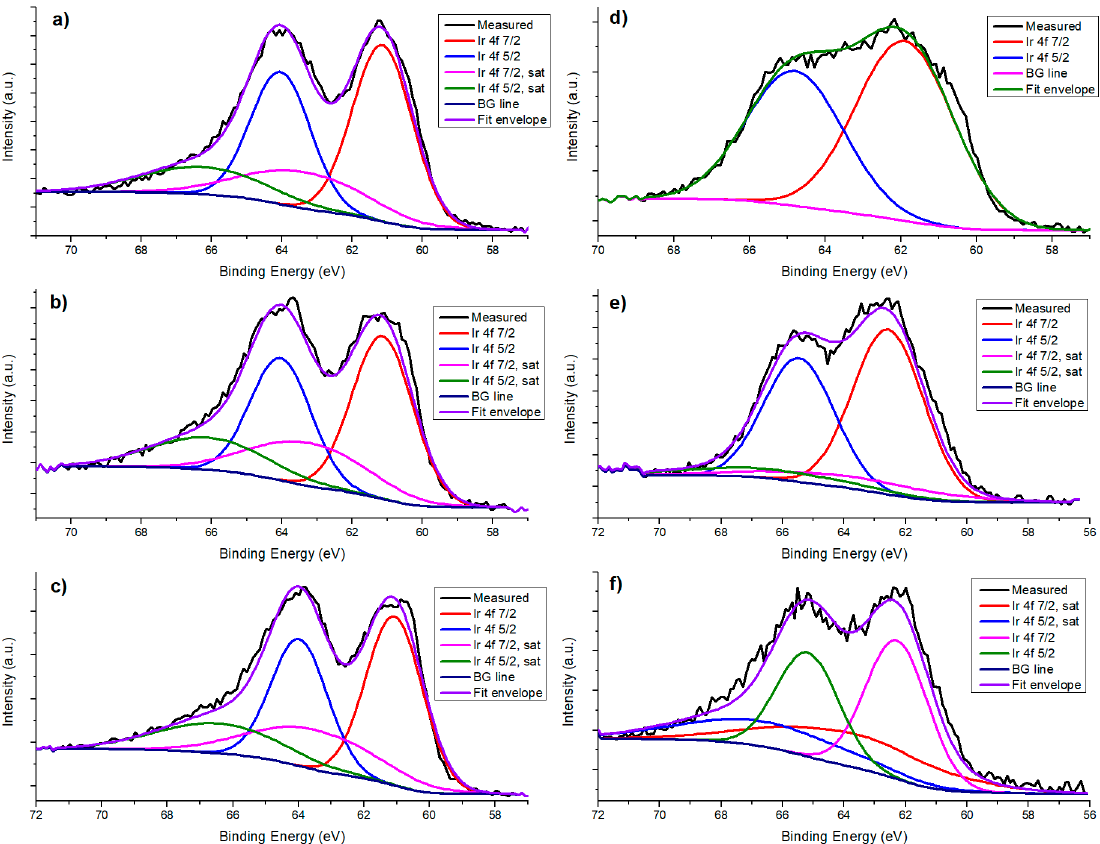
Figure 6. Ir 4f components for catalysts: ( a ) Ir/CeO 2 , ( b ) IrCu/CeO 2 , ( c ) IrNi/CeO 2 , ( d ) Ir/La 2 O 3 , ( e ) IrCu/La 2 O 3 , ( f ) IrNi/La 2 O 3 .